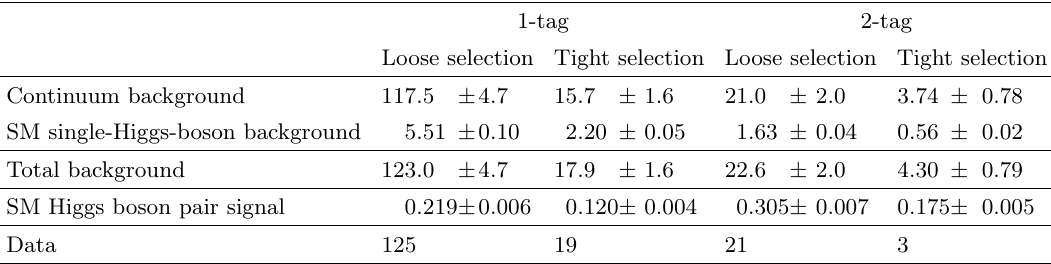
Table 3. Expected and observed numbers of events in the 1-tag and 2-tag categories for events passing the selection for the resonant analysis, including the m (cid:13)(cid:13) requirement. The event numbers quoted for the SM Higgs boson pair signal assume that the total production cross-section is 33 : 41 fb. The uncertainties on the continuum background are those arising from the (cid:12)tting procedure. The uncertainties on the single-Higgs-boson and Higgs boson pair backgrounds are from Monte Carlo statistical error. The loose and tight selections are not